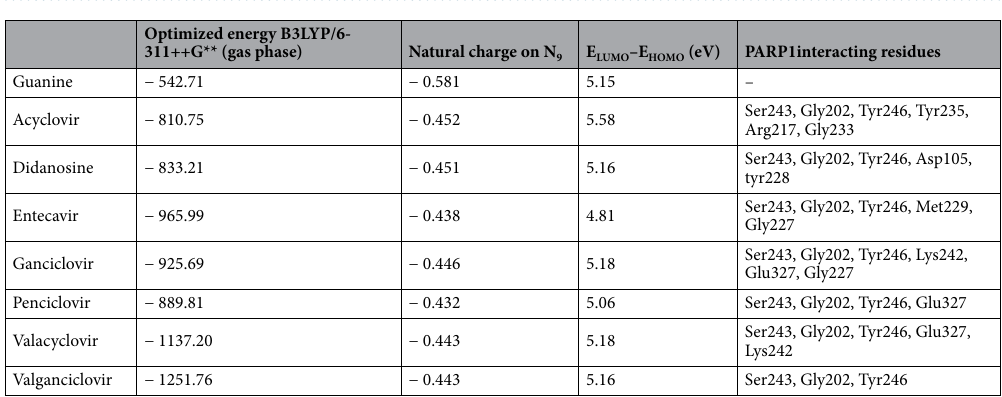
Table 2. The optimized energy (B3LYP/6–311++G**, gas phase), natural charge on N 9 , E LUMO –E HOMO (eV) and PARP interacting residues of guanine and its derivatives.